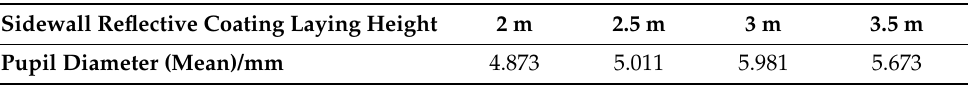
Table 9. Table of influence degree of side wall reflective paint placement height and pupil